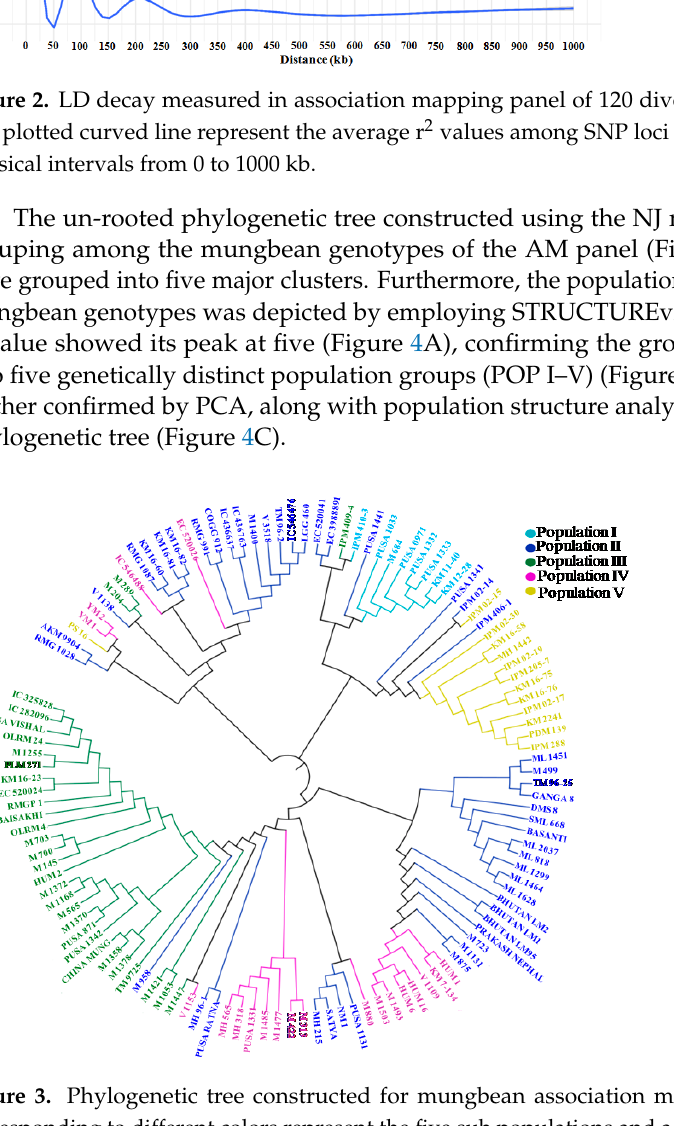
Figure 3. Phylogenetic tree constructed for mungbean association mapping panel. Genotypes corresponding to different colors represent the five sub populations and admixture in the population.